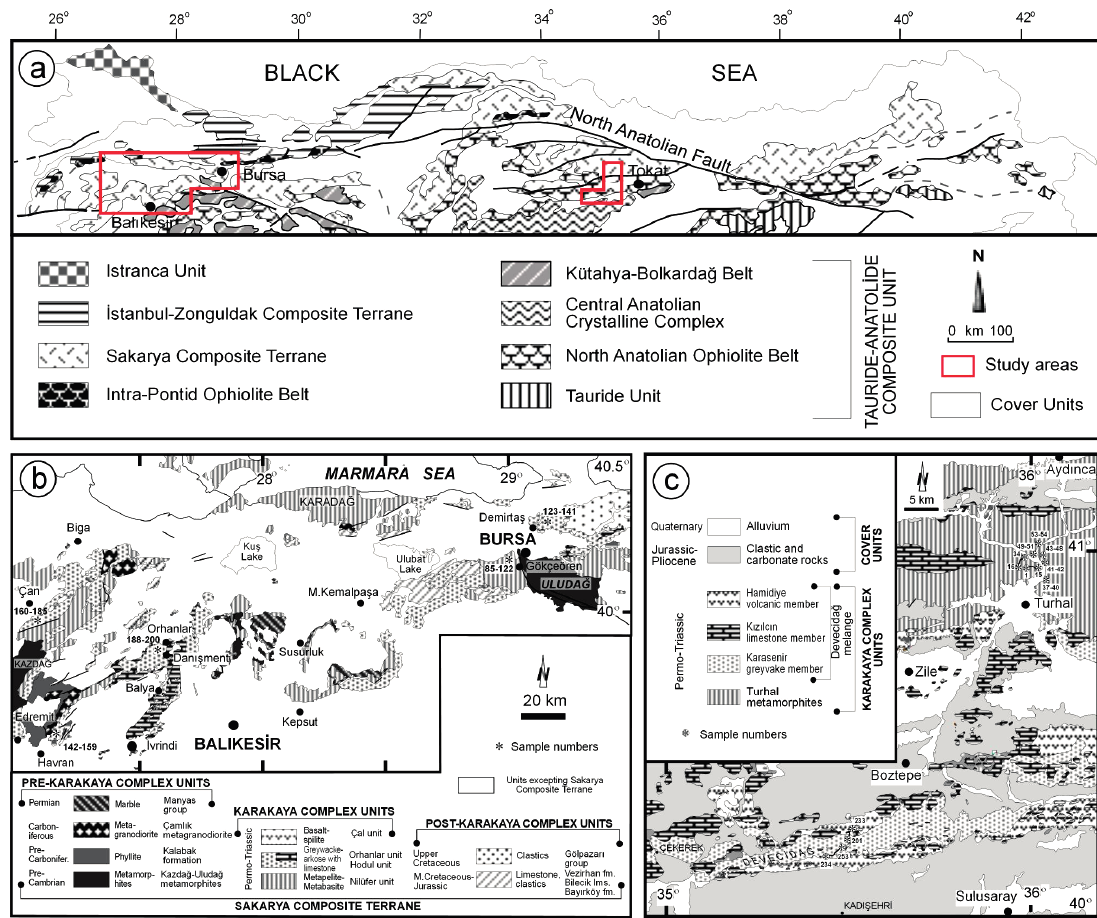
Figure 1. Simplified geologic-geotectonic maps of the Karakaya Complex and related units (unit boundaries [32] and unit determinations [23], ( a ) The Alpine tectonic units of northern Turkey (unit boundaries [32]; ( b ) NW Anatolia (modified after MTA [32]); ( c ) Central NE Anatolia